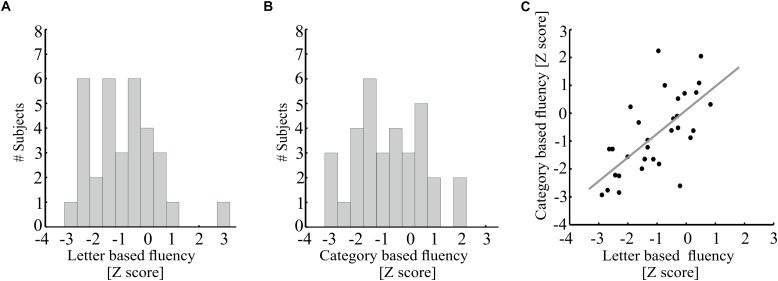
Behavioral performance on the fluency tasks by MS patients. (A,B) Distribution of age standardized letter-based (A) and category-based (B) fluency scores (N = 33). (C) Age-standardized letter-based fluency scores (X-axis) are plotted against age-standardized category-based fluency scores [N = 32, one additional participant was excluded from analysis due to a very high letter-based fluency score (Z = 2.97)]. A strong positive correlation is found between these two fluency measures (Pearson’s r = 0.66, p < 0.00005). The gray line represents the best linear fit to these measurements.